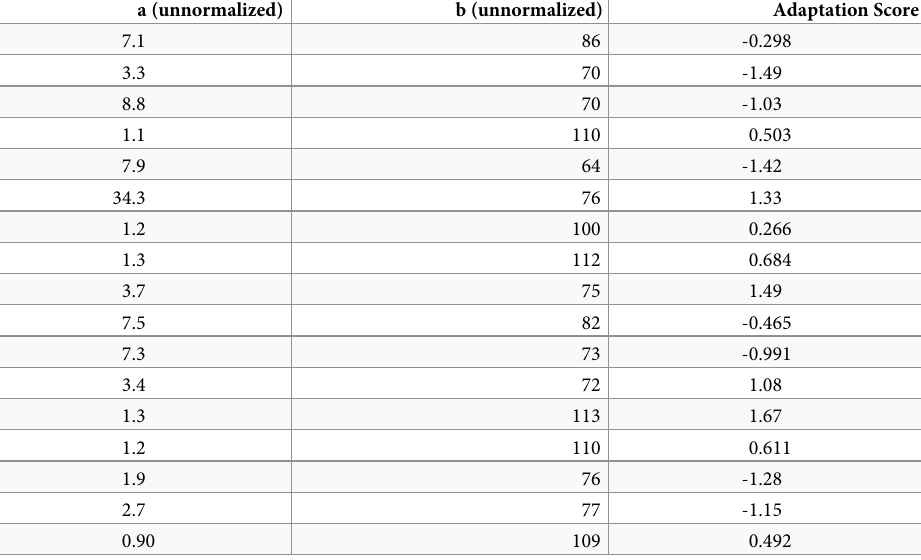
Table 1. Pre-normalized slopes (a) and Asympotes (b) and adaptation scores for all the